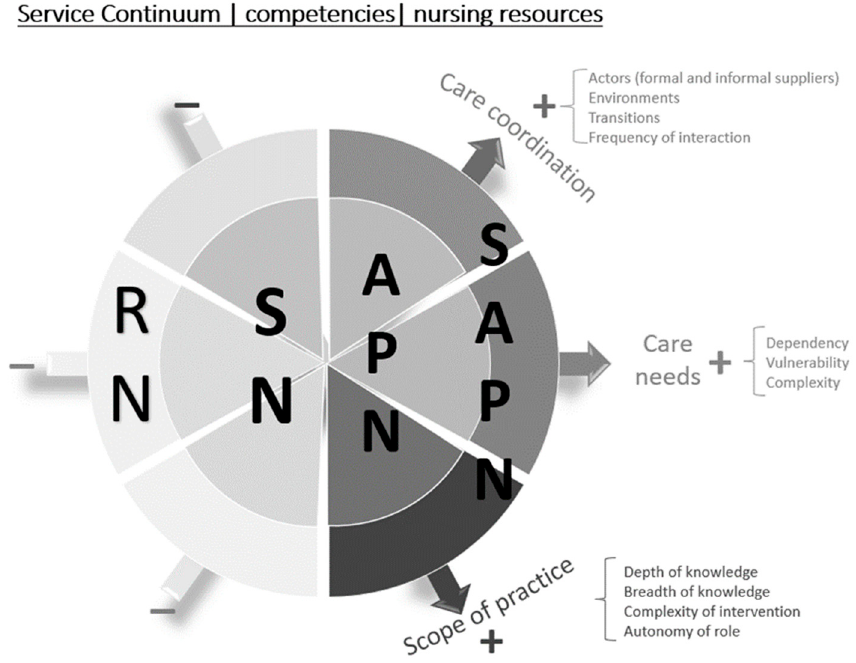
Figure 1. Axes for the definition of services and competencies of registered, specialist and advanced practice nurses